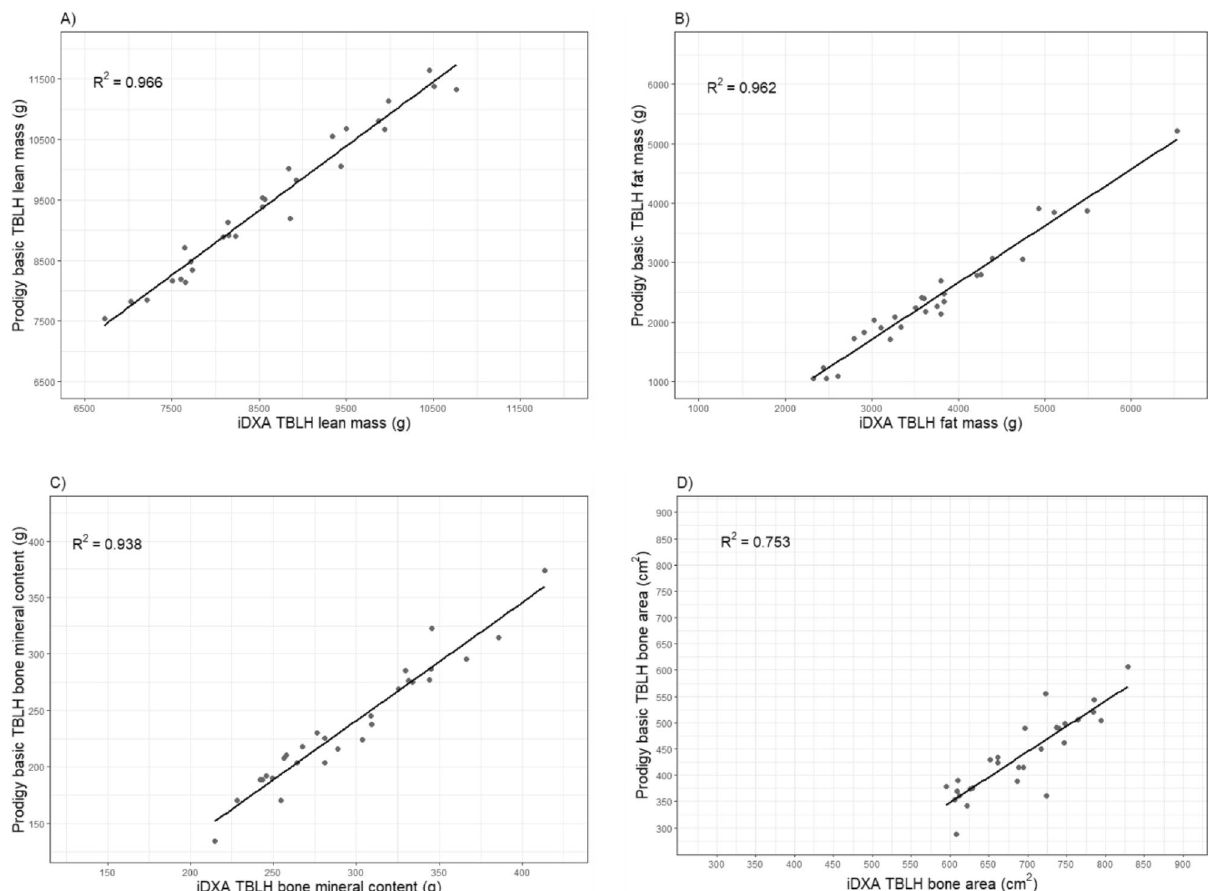
Figure 1. Scatterplots of total body less head (TBLH) estimates of ( A ) lean mass (g), ( B ) fat mass (g), ( C ) bone mineral content (g), and ( D ) bone area (cm 2 ) from the GE Lunar Prodigy basic and the GE Lunar iDXA.